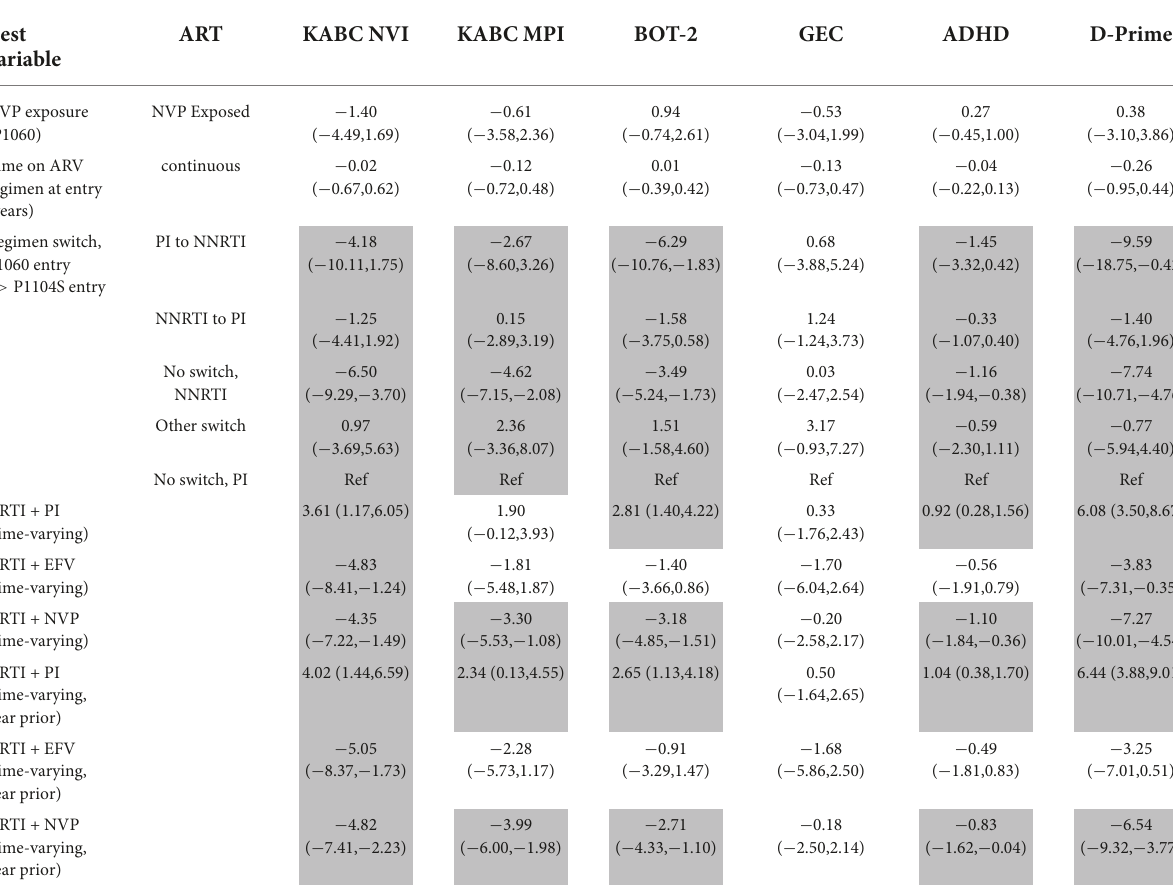
TABLE 5 ARV exposure associated with neuropsychological